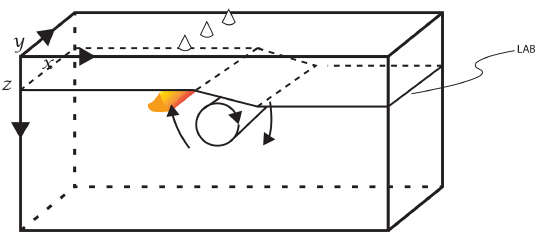
Figure 1. Schematic of edge-driven convection. A downwelling is promoted on the thick continental side of the lithospheric edge, triggering a passive upwelling that sustains mantle decompression melting (orange) and related volcanism parallel to the continent– ocean transition (cones). The lithosphere–asthenosphere boundary (LAB) is